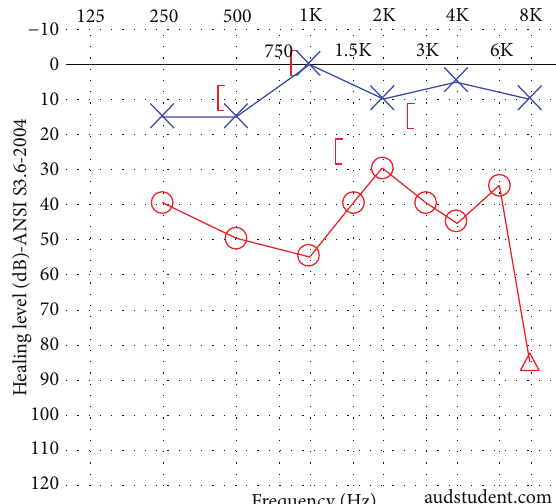
Figure 3: Audiogram of patient in Case 2 following trauma but prior to middle ear exploration. A right mixed hearing loss is present. This patient presented radiographically with both superior semicircular canal dehiscence and an ipsilateral incudomalleolar joint dislocation.